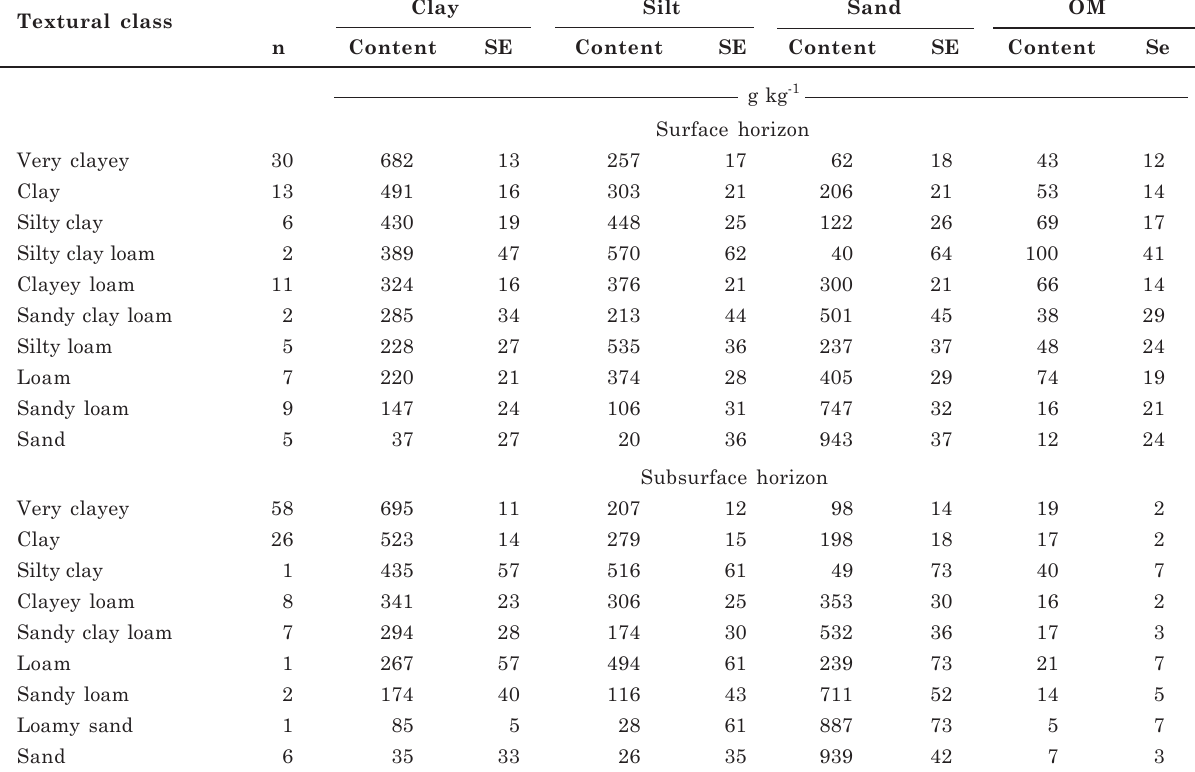
Table 2. Number of horizons (n), mean contents and standard error (SE) of the estimate for clay, silt, sand and organic matter (OM) in horizons grouped according to the textural classes of the soils of the State of Santa